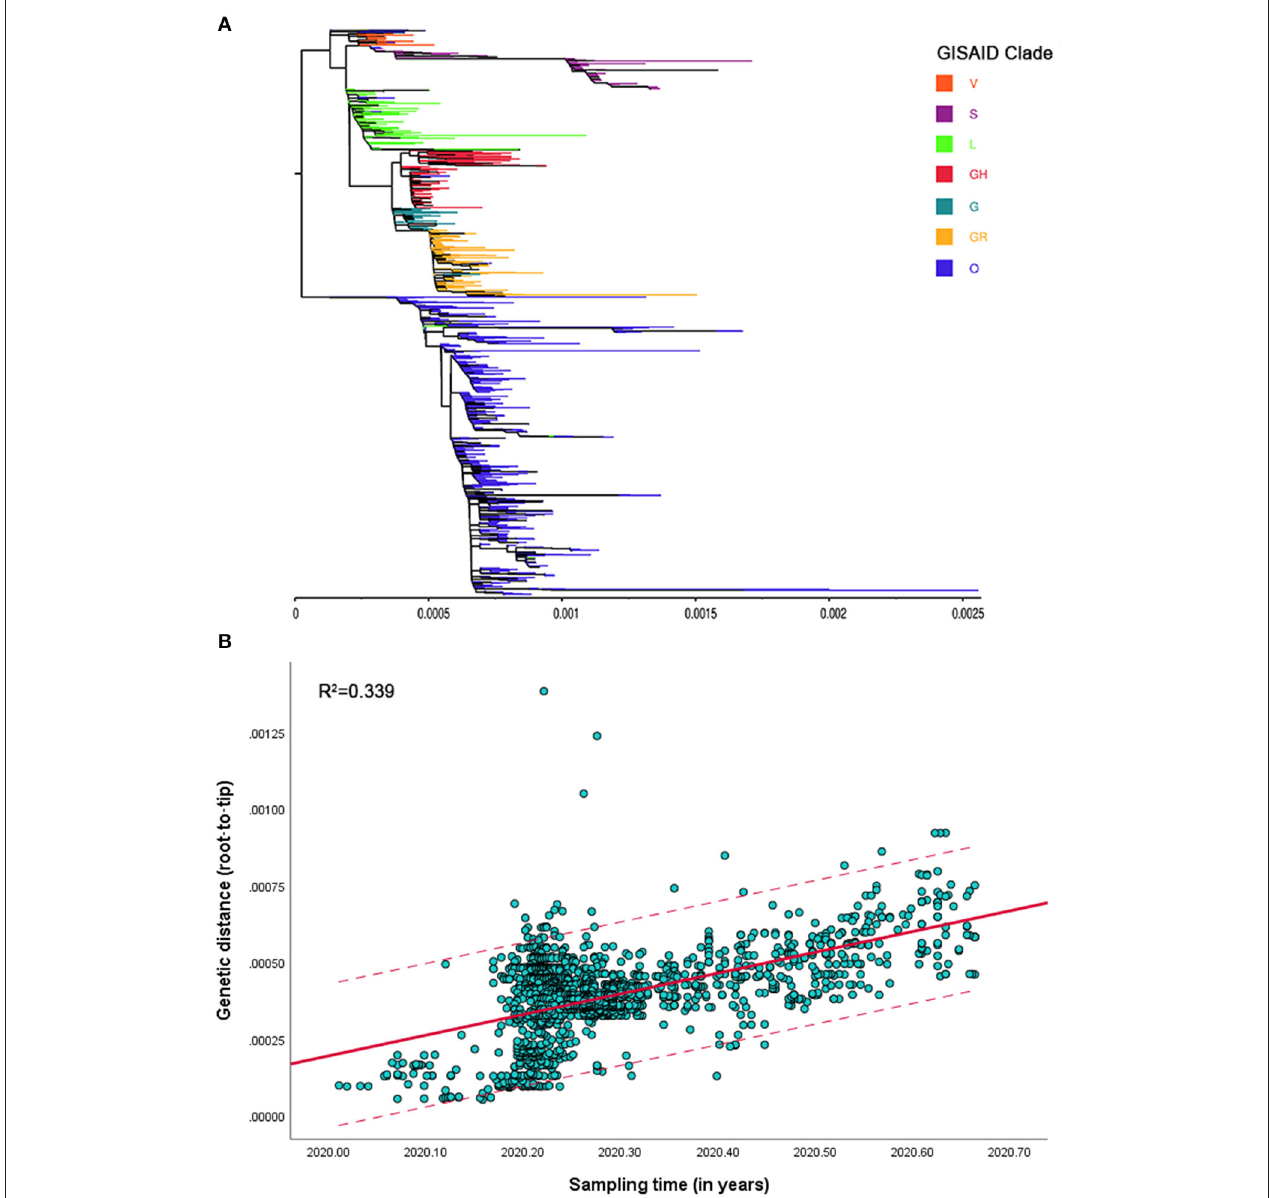
FIGURE 1 | (A) Maximum-likelihood (ML) phylogenetic tree of severe acute respiratory syndrome coronavirus 2 (SARS-CoV-2) strains isolated from Southeast Asia using complete genomes. (B) Root-to-tip regression based on the ML phylogenetic tree; the solid red line and dotted lines represent the regression line and upper or lower limits of 95% confidence interval (CI),